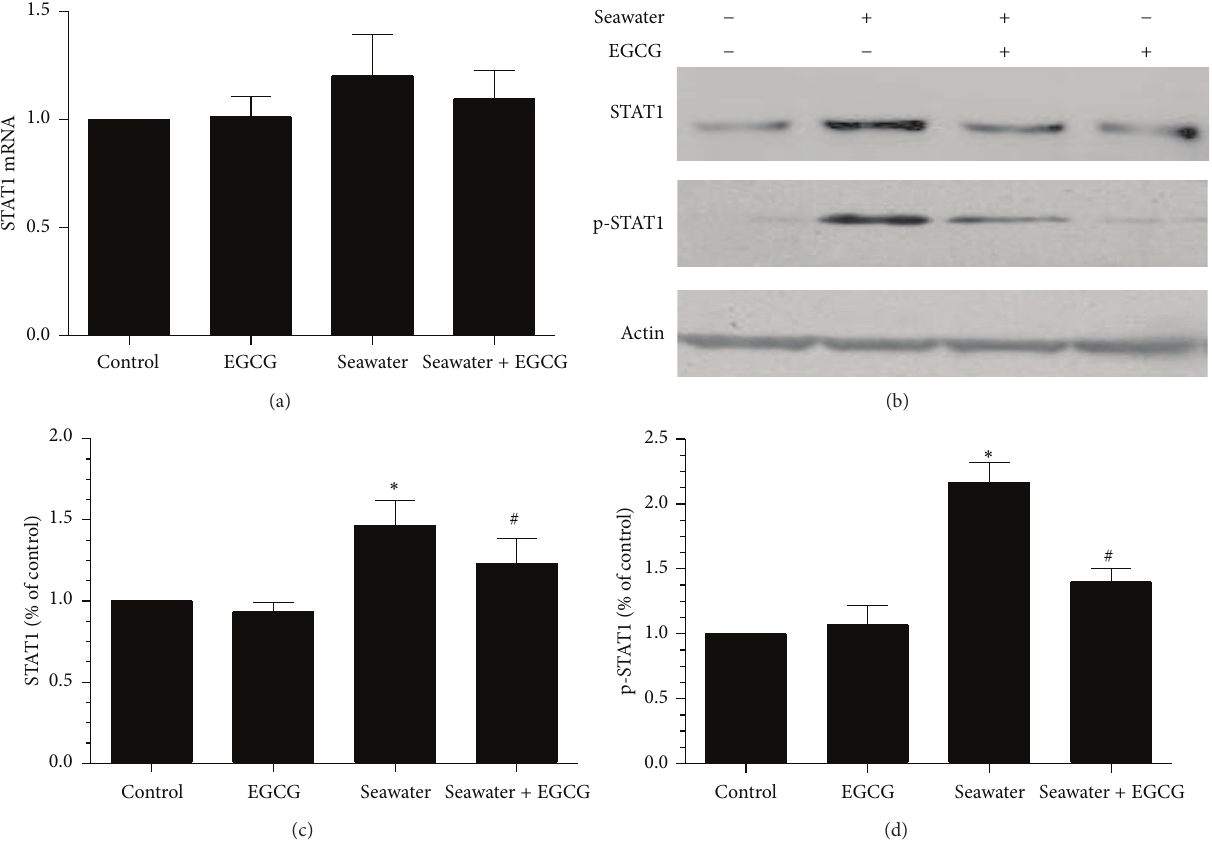
Figure 10: Effect of EGCG pretreatment on the expression of STAT1 and p-STAT1 in the cell line NR8383. (a) mRNA expression of STAT1 in NR8383 cells. (b) Representative western blot for the phosphorylated STAT1 and the total STAT1 protein in different groups. (c)-(d) Summarized data of the total (c) and the phosphorylated (d) STAT1 protein level in different groups. Data represent three independent experiments and are expressed as mean ± SEM; ∗ 𝑃 < 0.05 versus control group; # 𝑃 < 0.05 versus seawater group.